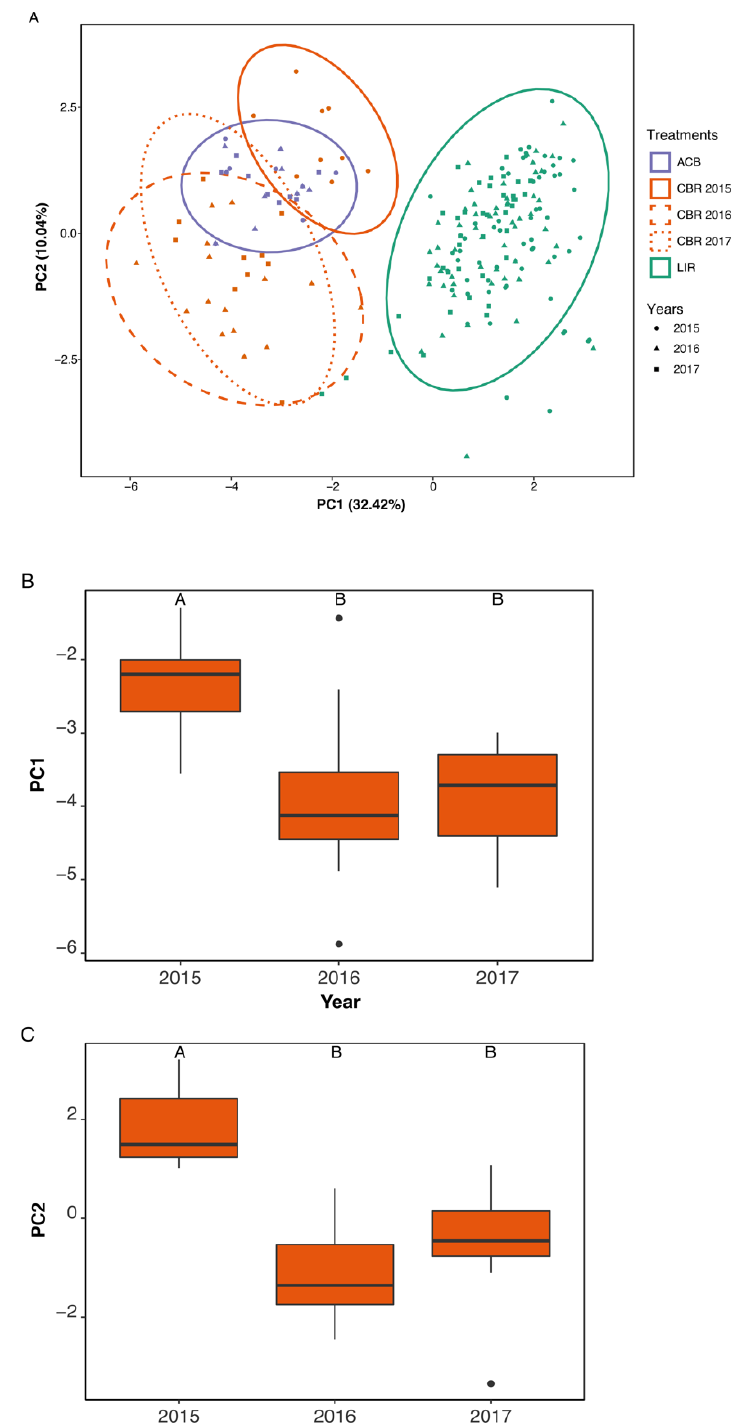
Figure 3. PCA of local habitat transect data (BASS) from 2015–2017, coded by treatment (color) and year (shape), with 95% confidence interval ellipses for group centroid based on standard deviation (outlining ellipses) ( A ). ANOVAs of CBR data along PC1 ( B ) and PC2 ( C ), with significantly different values (α = 0.05) within each graph, as determined by Tukey’s HSD, marked by different letters; shared letters represent nonsignificant differences. [21,22].